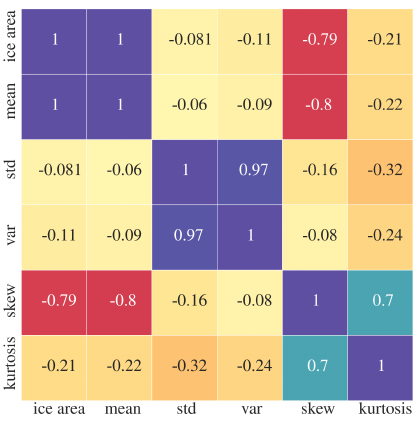
Figure 5. The Pearson’s coefficients of features in sub-region No.